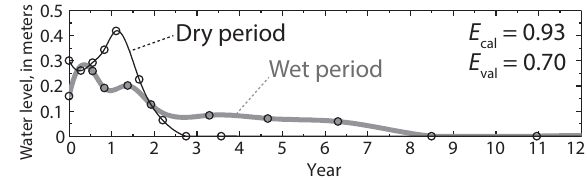
Figure 9. Example W2: nonparametric impulse-response functions for well LA88C using a total of 18 control